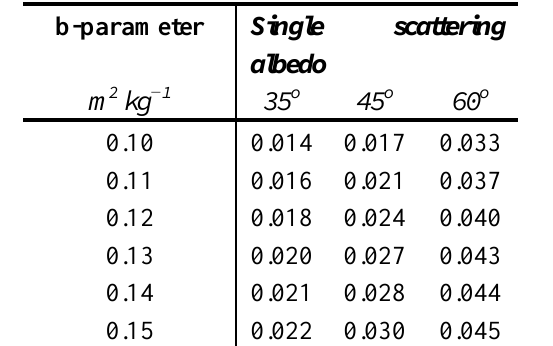
Table 5. Single scattering albedo ( ω ) inverted from LRAD T ( W = 4.2 kg m −2 ) assuming a range b parameters from 0.10 to 0.15 m 2 kg −1